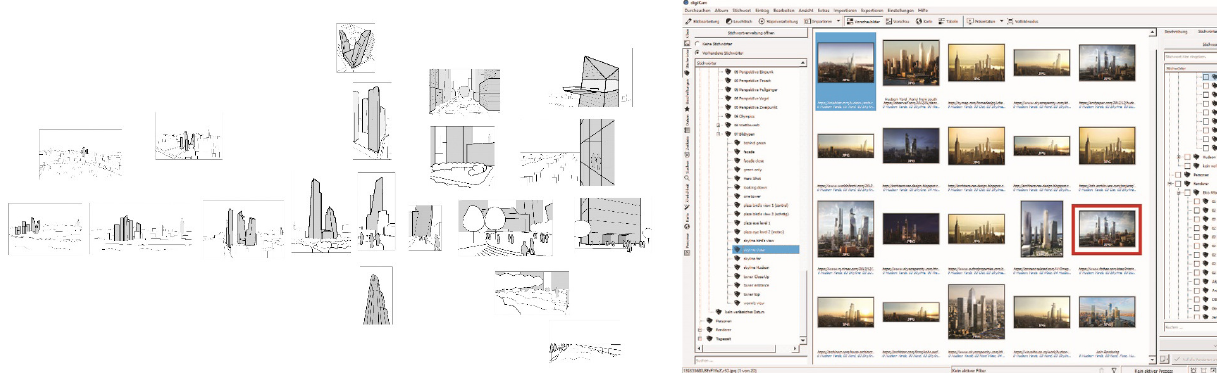
Figure 3. An overview of the image types produced for Hudson Yards (left) and a look into one of the image types of Hudson Yards (screenshot from the image database,